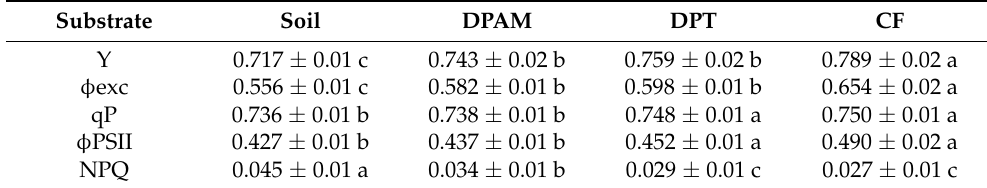
Table 3. Variation of the fluorescence parameters of melon leaves grown on a different substrate. DPAM: compost of date palm residues and animal manure; DPT: compost of date palm trunk; CF: coconut fiber, compared with soil substrate. The maximum quantum yield of photosystem